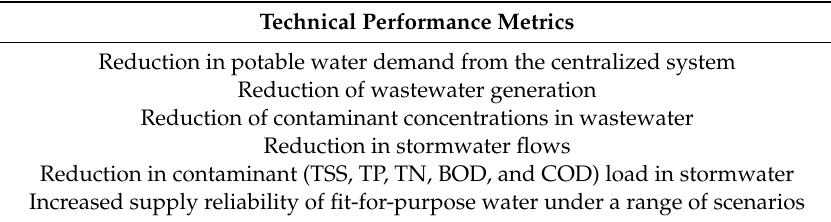
Table 2. Technical performance metrics for supply augmentation e ff orts [25].